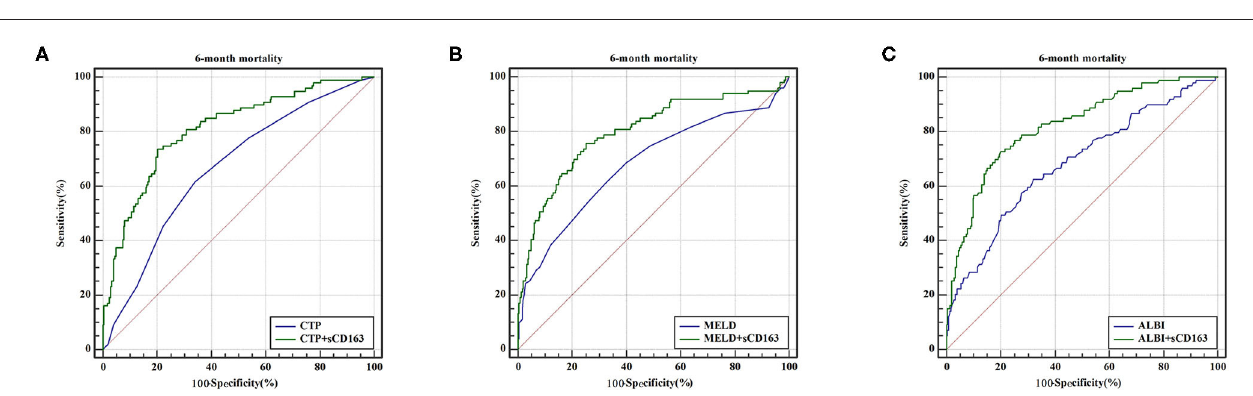
for the prediction of short-term and long-term outcomes in DeCi patients, which highlights a key role of macrophage activation in the development and progression of